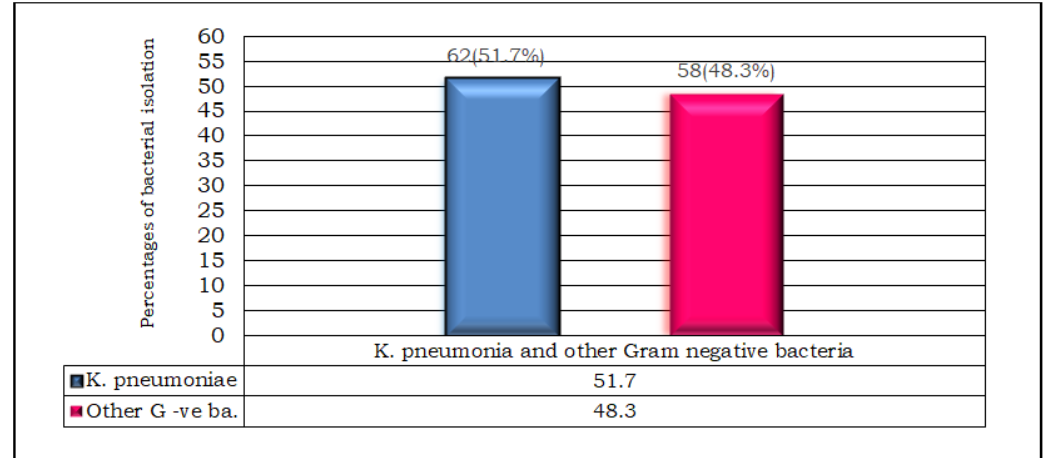
Fig. 2. Percentage of isolation of 120 isolates of K. pneumonia and other Gram-negative bacteria depending on Microbiological tests